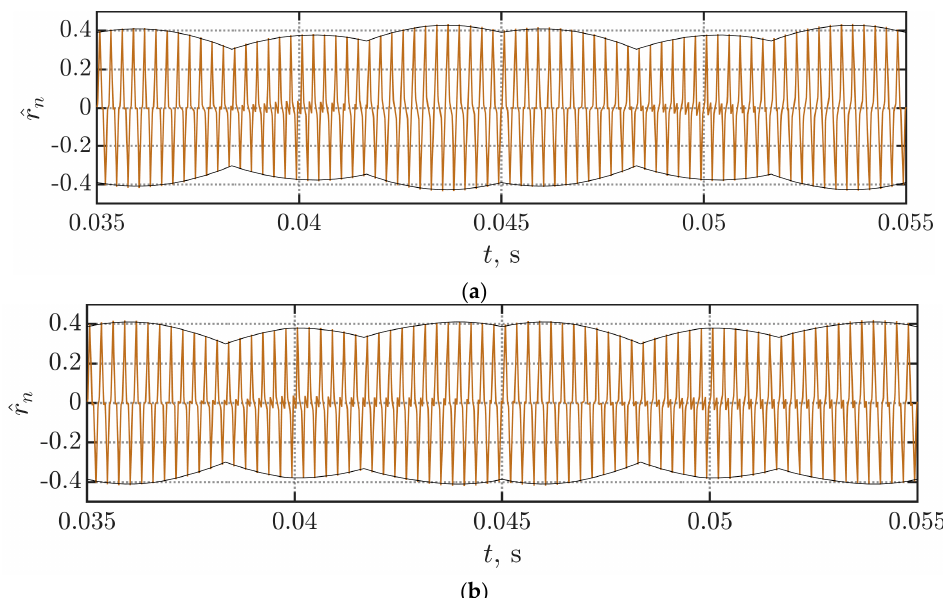
Figure 11. Normalized current ripples with modulation index unbalance ( m a = 0.3, m b = 0.4, m c = 0.5) with their primary (black) current ripple envelopes in case of SPWM ( a ) and CPWM ( b ).